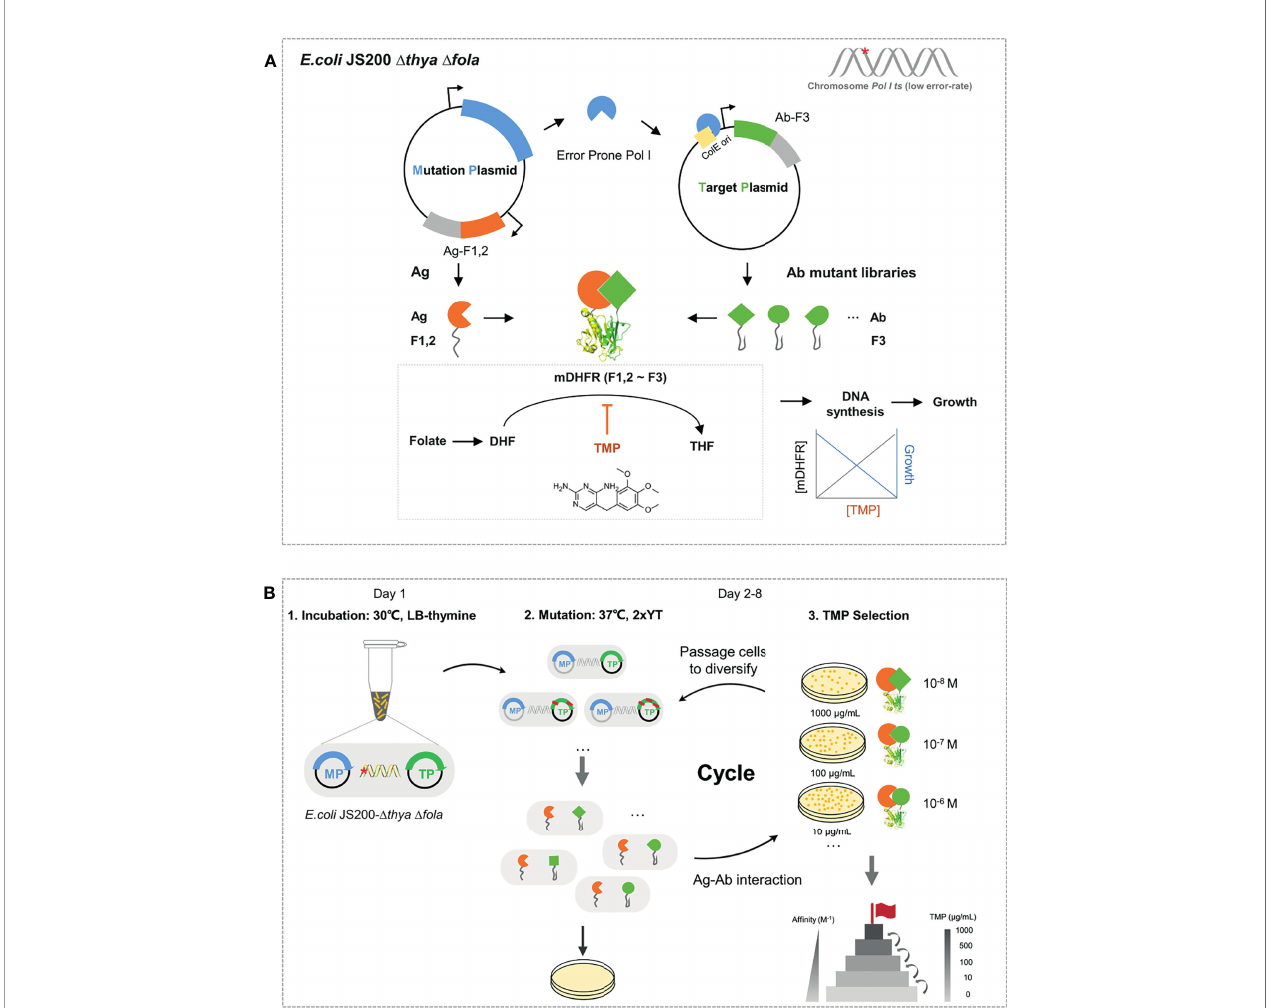
FIGURE 1 | Schematic and work fl ow of the EASINESS. (A) Anatomy of the key cell in EASINESS, i.e., E. coli JS200- D thya D fola . E. coli JS200- D thya D fola carries two plasmids: the mutation plasmid (MP), which mainly enables mutagenesis, and the target plasmid (TP), which encodes an evolving antibody part (Ab-F3). The antigen part (Ag-F1,2) was expressed in MP. The reconstitution survives on selecting media with trimethoprim (TMP). The resistance to TMP is proportional to the binding af fi nity between Ag and Ab. The red star indicates E. coli JS200 with the gene thya and fola knocked out. (B) The work fl ow of EASINESS. On day 1, the E. coli JS200- D thya D fola with MP and TP was grown in LB medium with thymine at 30°C overnight and then was shifted to 37°C in 2× YT medium with thymine to mutagenesis. On days 2 – 8, mutation and screening at 37°C were conducted. Strains were plated to select positive clones with reconstituted mDHFR activity through Ag-Ab binding. To select Ab with higher af fi nity to the designated target protein, the positive clones were iterated on plates with higher concentrations of TMP until the concentration reached 1,000 ng/ m l. The chemical structural formula of TMP was drawn in InDraw web version